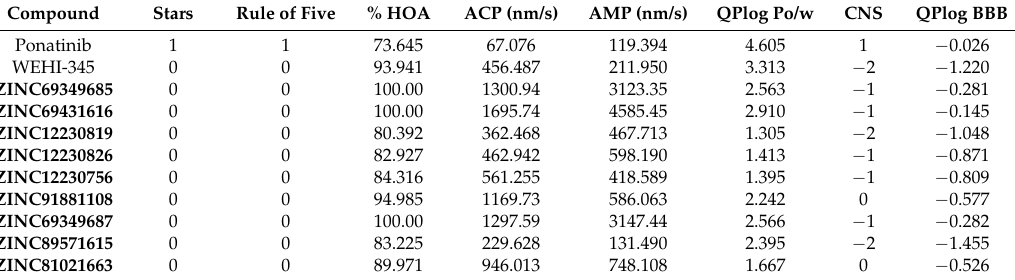
Table 8. Pharmacokinetic properties of nine selected compounds as well as ponatinib and WEHI-345. Compound